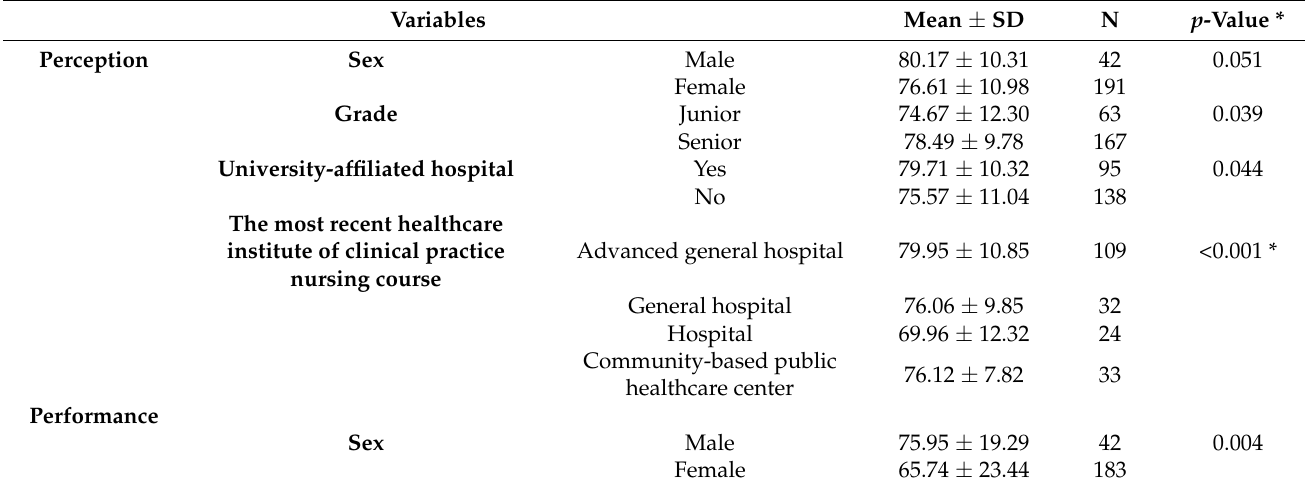
Table 2. Non-parametric analysis ( n = 233).